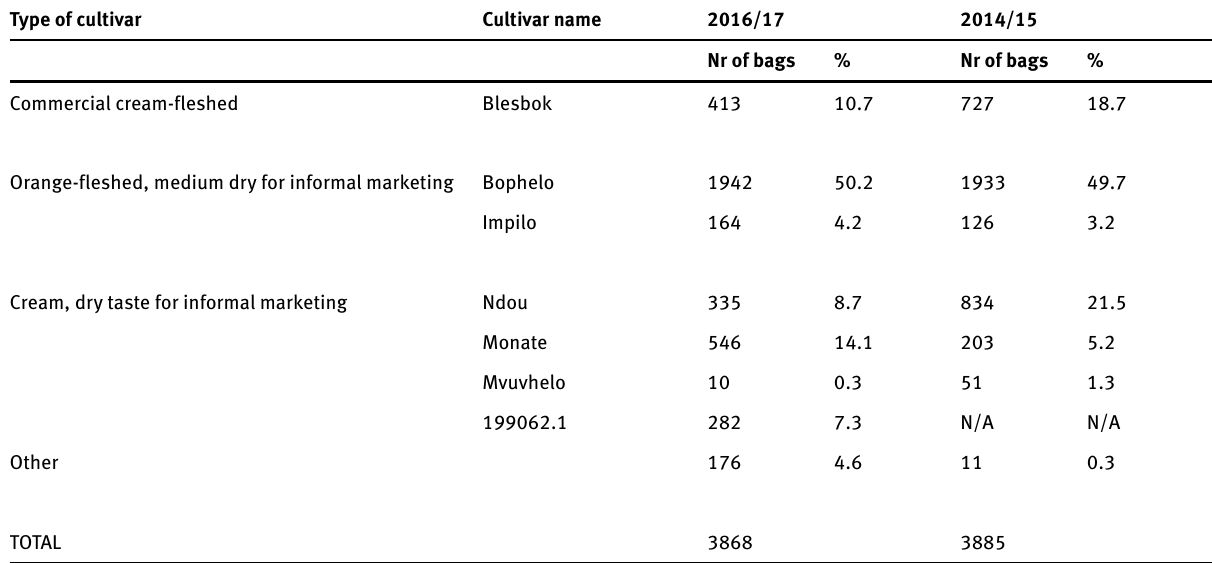
Table 6: Number of bags of sweet potato vines disseminated in South Africa from decentralized small-scale commercial nurseries during 2014/15 and 2016/17 Type of